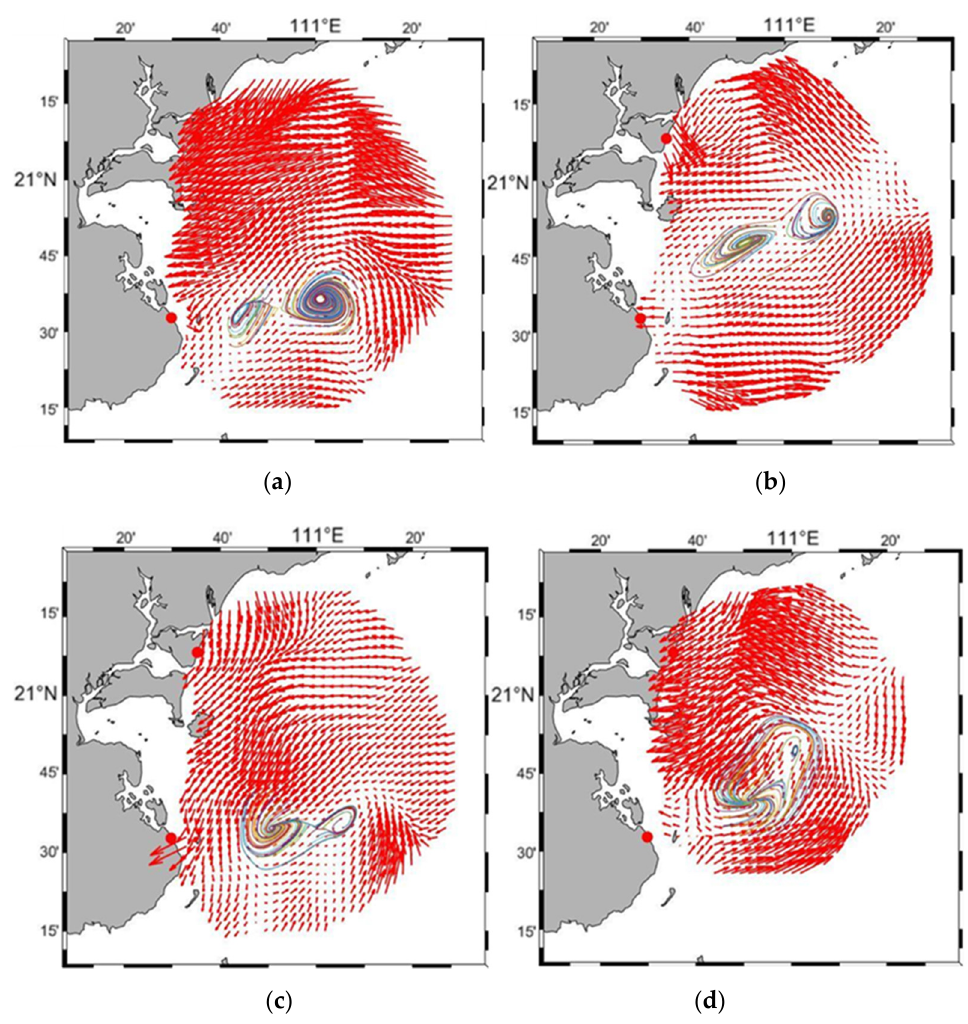
Figure 10. The four merging stages of two eddies rotating in the same direction. ( a ) Encounter (11:40), ( b ) contact (15:20), ( c ) partial merger (19:00), and ( d ) complete merger (22:40) on 1 October 2017.